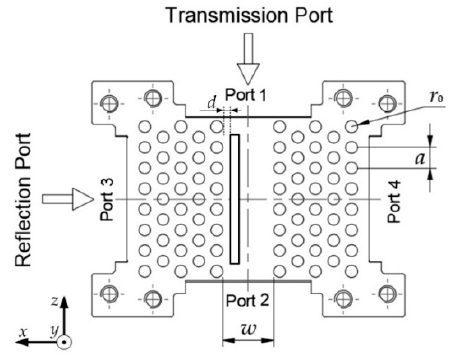
Figure 2. The sectional view of the MO isolators.